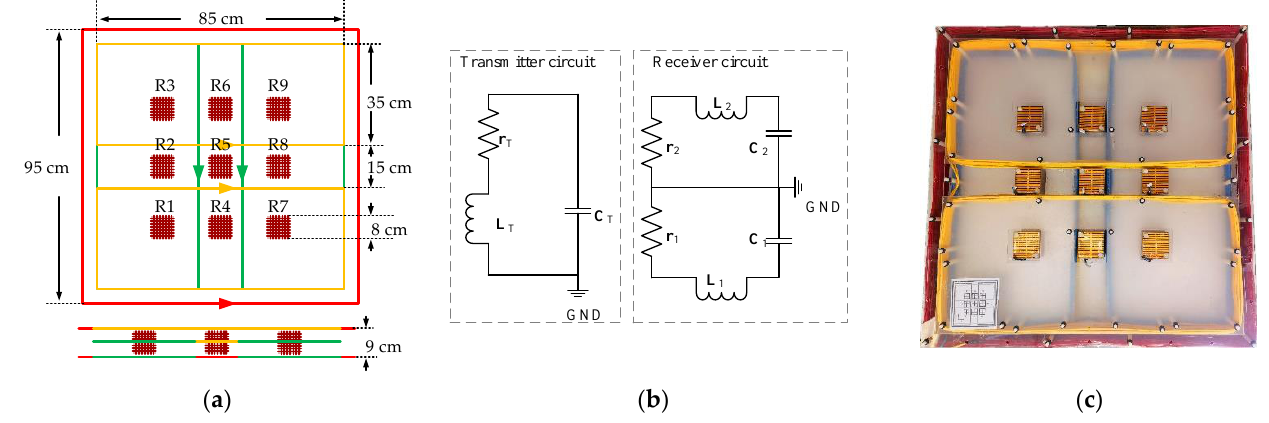
Figure 2. ( a ) Structure of towed TEM sensor array; ( b ) equivalent circuit diagram; ( c ) physical pic- ture of the towed sensor. of the towed